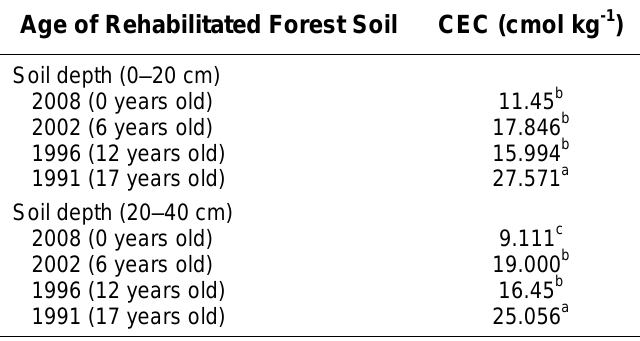
Soil CEC of a Rehabilitated Forest Soil (Different Ages) Age of Rehabilitated Forest